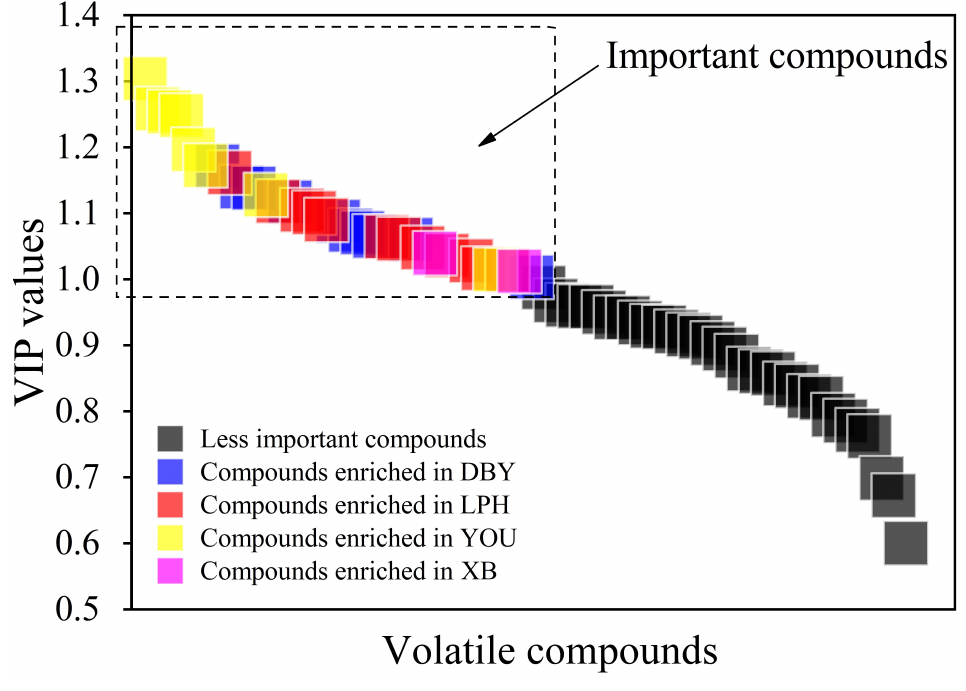
Figure 4. The variable importance for the projection in PLS-DA model. DBY, Dabaiyou apricot; LPH, Luopuhongdaike apricot; YOU, You apricot; XB, Xiaobai apricot. The seven differentiated volatile compounds whose VIP > 1.0 are shown in Table